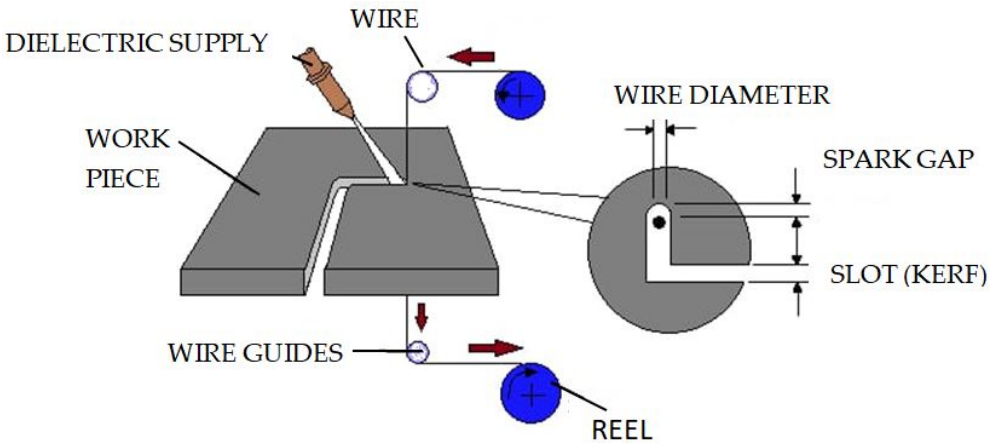
Figure 2. Working principle of wire EDM.